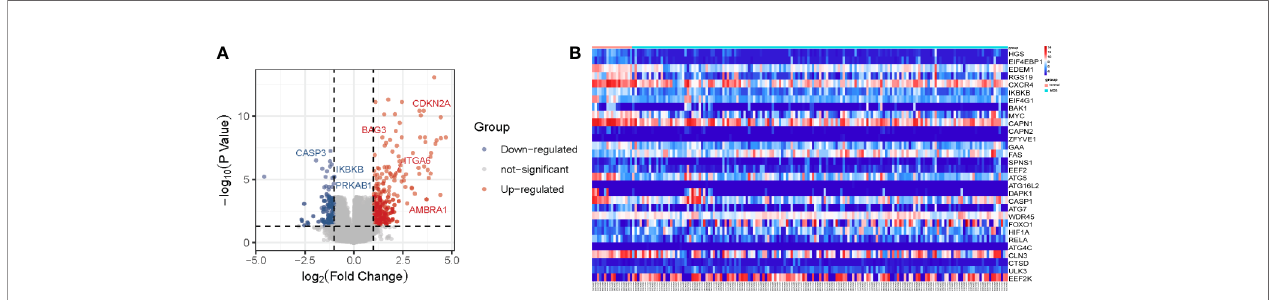
FIGURE 1 | Differentially expressed ARGs in MDS. Volcano map (A) showing all differentially expressed genes between patients with MDS and healthy subjects. Signi fi cantly upregulated genes are shown as red dots, signi fi cantly downregulated genes as green dots, and genes showing no difference in expression are shown as grey dots. Heatmap (B) showing the expression of top 30 ARGs in MDS and normal samples.